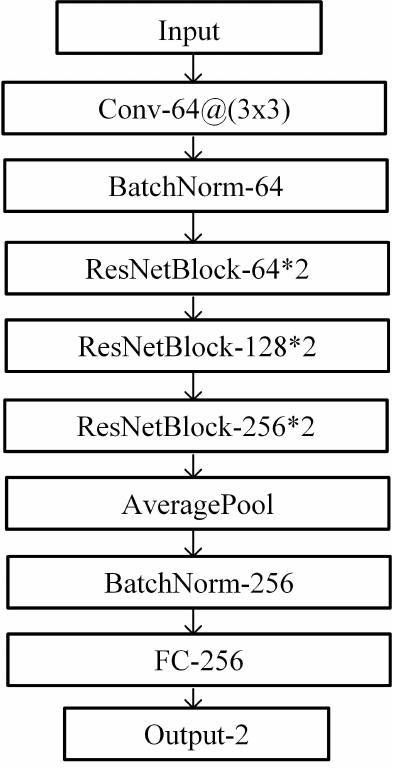
Figure 3. The improved ResNet network structure in this paper.